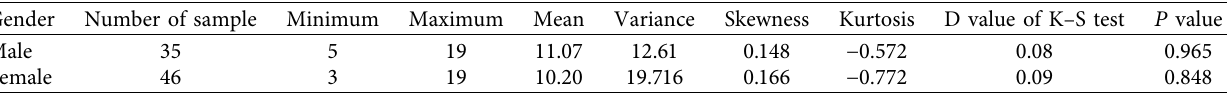
Table 4: Statistical characteristics and normal distribution test of incubation time of different genders.